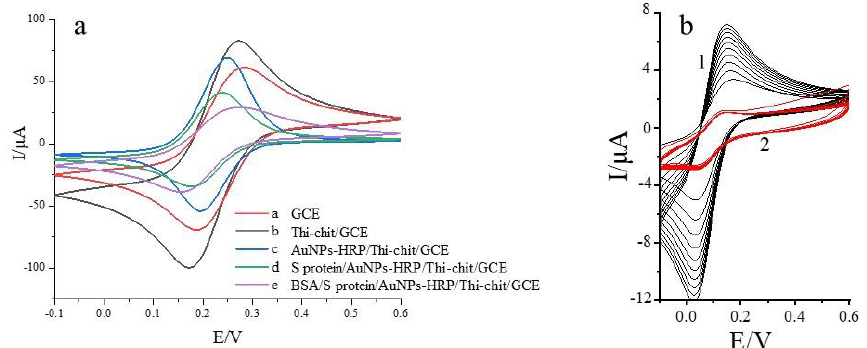
Figure 2. ( a ) Cyclic voltammetry characterization of spike protein receptor sensor electrode assembly modifications. ( b ) the impact of thionine on electrochemical properties characterized by cyclic voltammetry; curve 1 is the cyclic voltammogram of Thi-Chit/GCE and curve 2 is the cyclic voltammogram of Chit/GCE. The peak current increases gradually when thi is present, indicating that thi facilitates the transfer of electrons between the electrode and the substrate. Cyclic voltammetry was performed in 1 × 10 − 3 mol/L K 3 Fe(CN) 6 (containing 0.20 mol/L KNO 3 ) solution with a scanning potential range of − 0.1 to 0.6 V and a scanning rate of 50 mV/s, using a three-electrode system; the prepared S protein receptor sensor was used as the working electrode, Ag/AgCl electrode as the reference electrode and platinum wire electrode as the counter electrode.